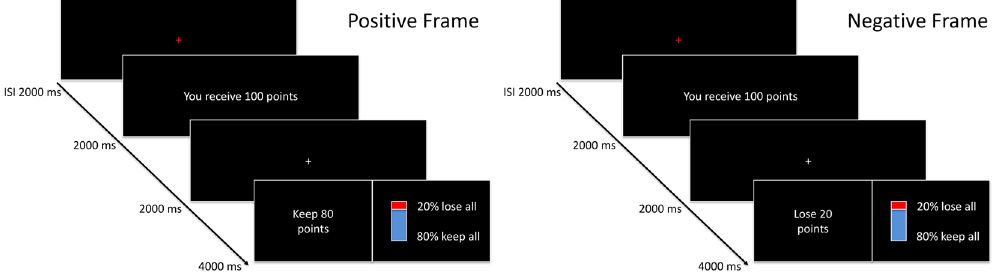
Figure 3. Illustration of the experimental task adapted from 29 . An initial offer was presented and the participants’ task was to decide whether they wanted to choose the safe option and keep a fixed amount of the initial points or to contend for the whole amount of the initial offer by choosing the risky option. The information in the safe option was framed either positively (“Keep 80 points” out of the initially received 100 points) or negatively (“Lose 20 points” out of the initially received 100